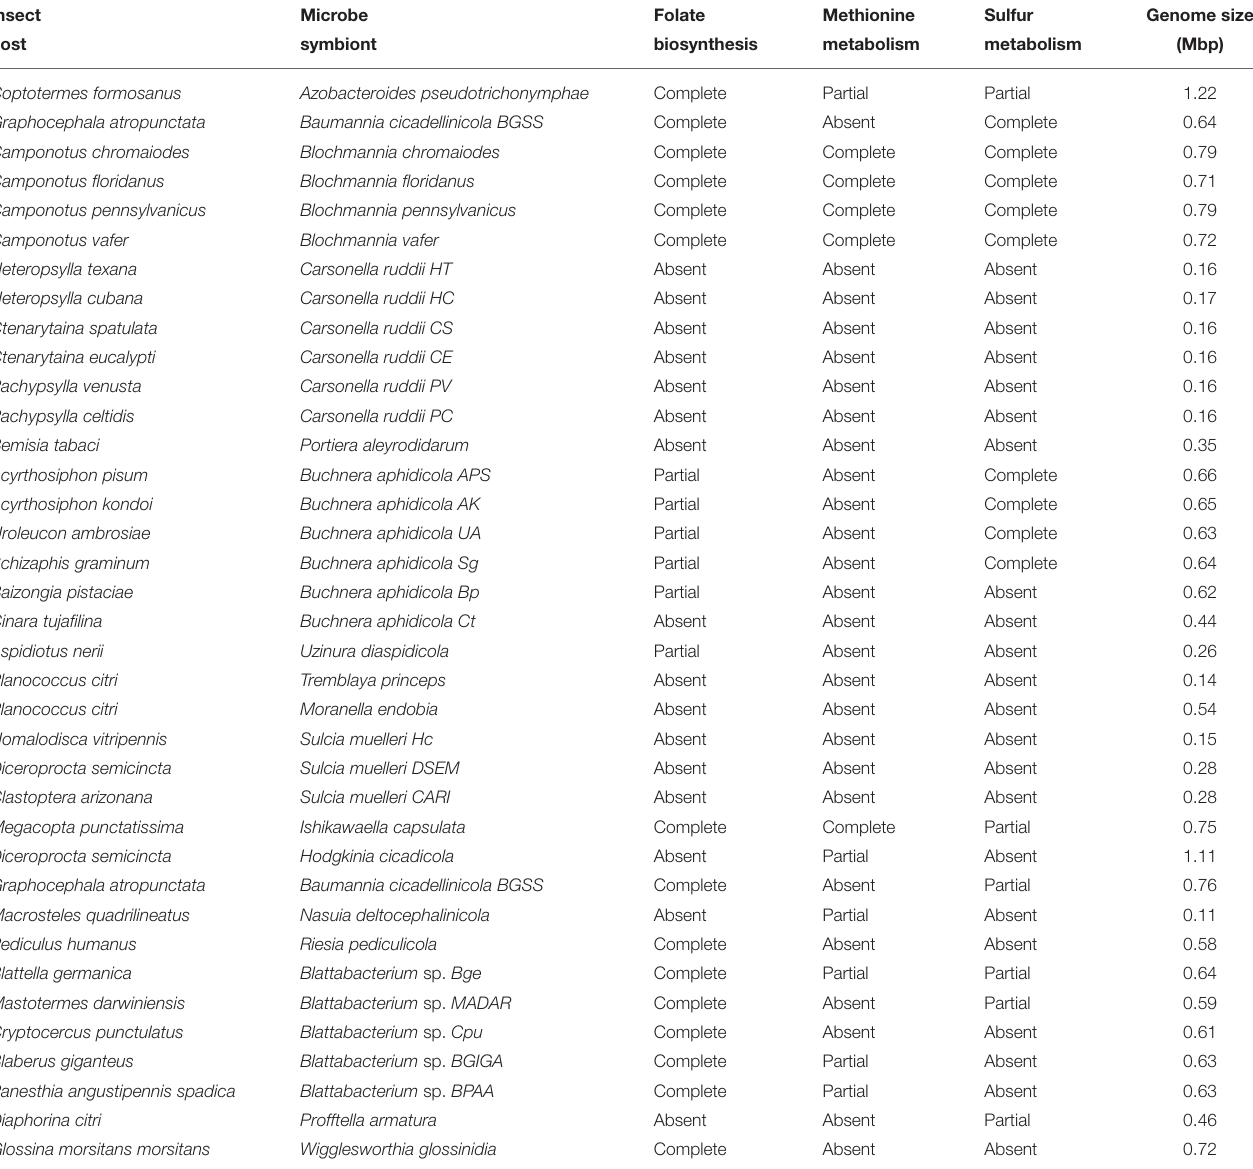
TABLE 2 | Presence and absence of pathways from obligate symbionts of insects with fully sequenced